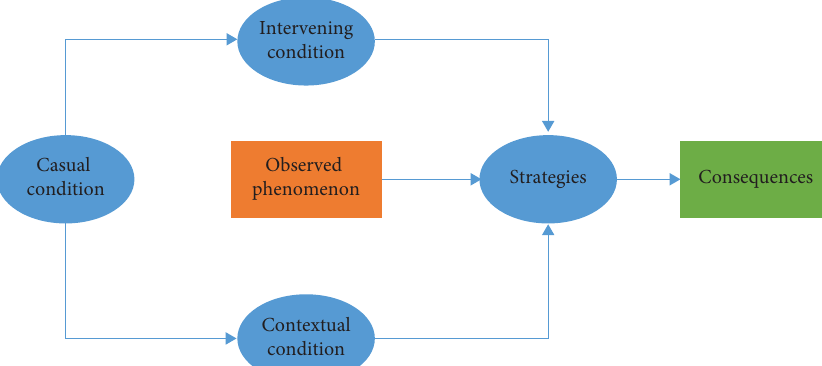
Figure 1: Te visual model of the grounded theory